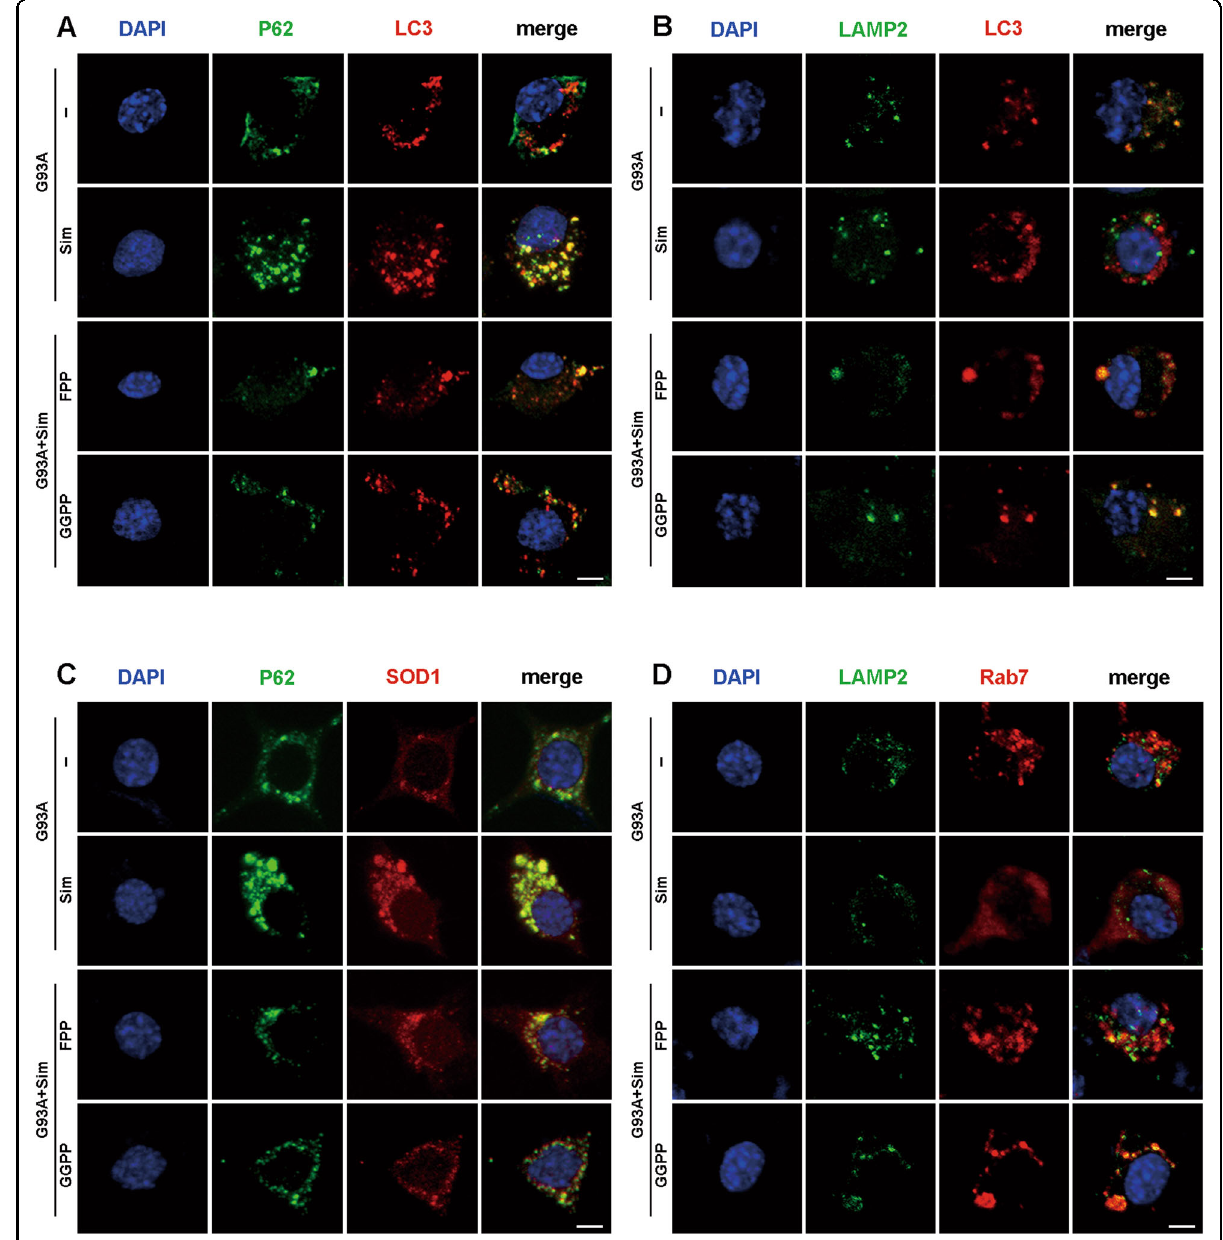
Fig. 8 FPP or GGPP rescued defects of autophagic fl ux in simvastatin-treated NSC34-hSOD1 G93A cells. A – D Representative intensity projections from NSC34-hSOD1 G93A cells untreated or treated with the indicated chemicals: simvastatin (1µM), simvastatin (1µM) + FPP (10µM) or simvastatin (1µM) + GGPP (10µM) for 24h. Nuclei were stained with DAPI (blue). A Immuno fl uorescence labeling of P62 (green) and LC3 (red). P62- and LC3- double positive puncta indicating autophagosome formation (Scale bars, 5 μ m). B Immunostaining of LAMP2 (green) and LC3 (red) in per cell group. Double positive structures for LAMP2 and LC3 representing fusion of autophagosomes with lysosomes (Scale bars, 5 μ m). C Immuno fl uorescence labeling of P62 (green) and SOD1 (red) in per cell group (Scale bars, 5 μ m). D Immuno fl uorescence labeling of LAMP2 (green) and Rab7 (red) in per cell group (Scale bars, 5 μ